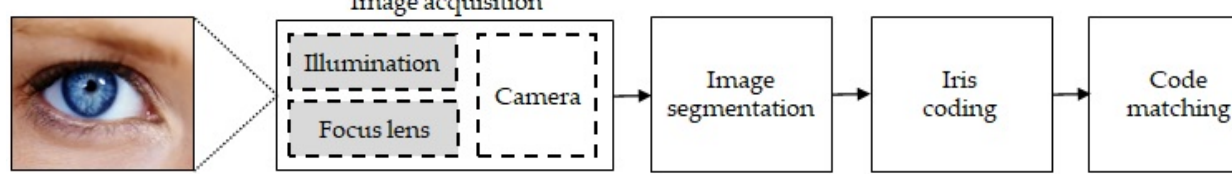
Figure 2. Basic principles of an iris recognition system.